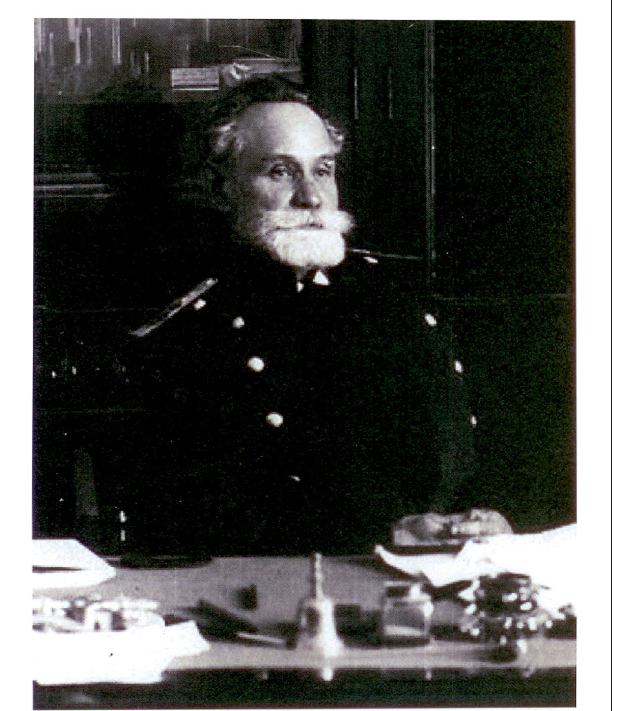
FIGURE 1 | Santiago Ramón y Cajal . Cajal in a photograph from approximately 1906 when he was awarded the Nobel Prize in Physiology or Medicine (image reproduced with permission from the Cajal Institute, Madrid). FIGURE 2 | Ivan Petrovich Pavlov . Pavlov at his desk in the Imperial Military